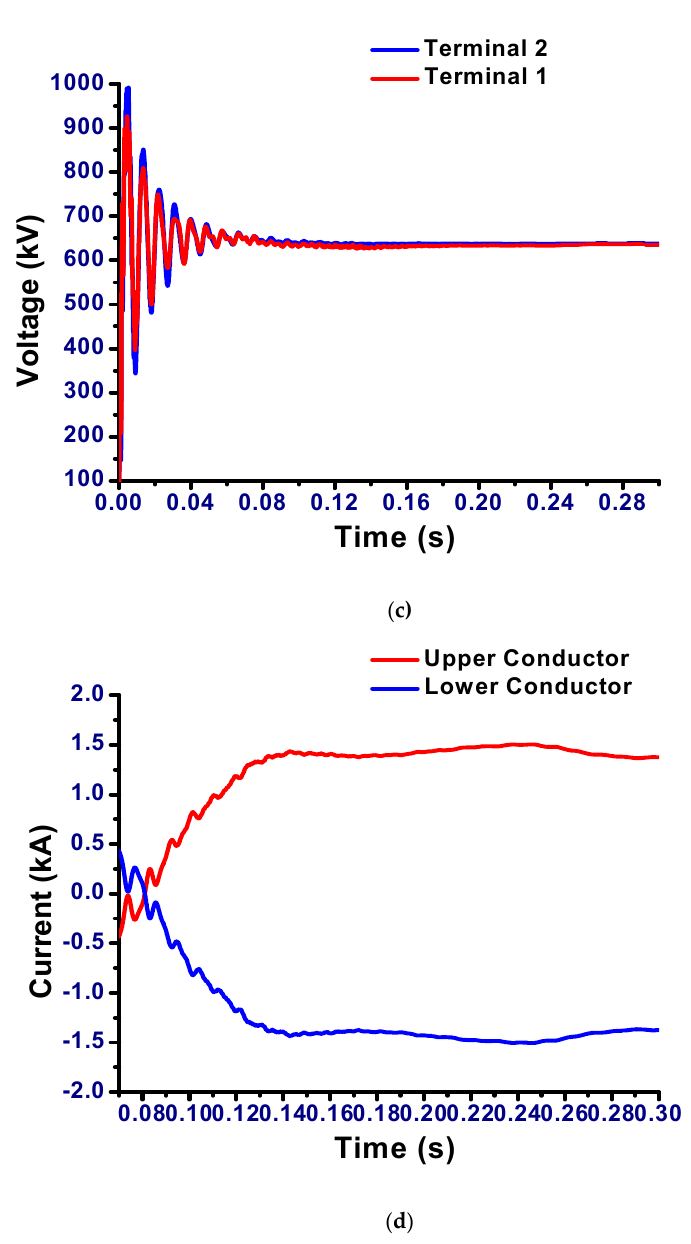
Figure 5. Results of ( a ) P 1 , P 2 at T1and T2; ( b ) Q 1 , Q 2 at T1and T2; ( c ) DC bus voltage at T1and T2; and ( d ) current in the DC line.